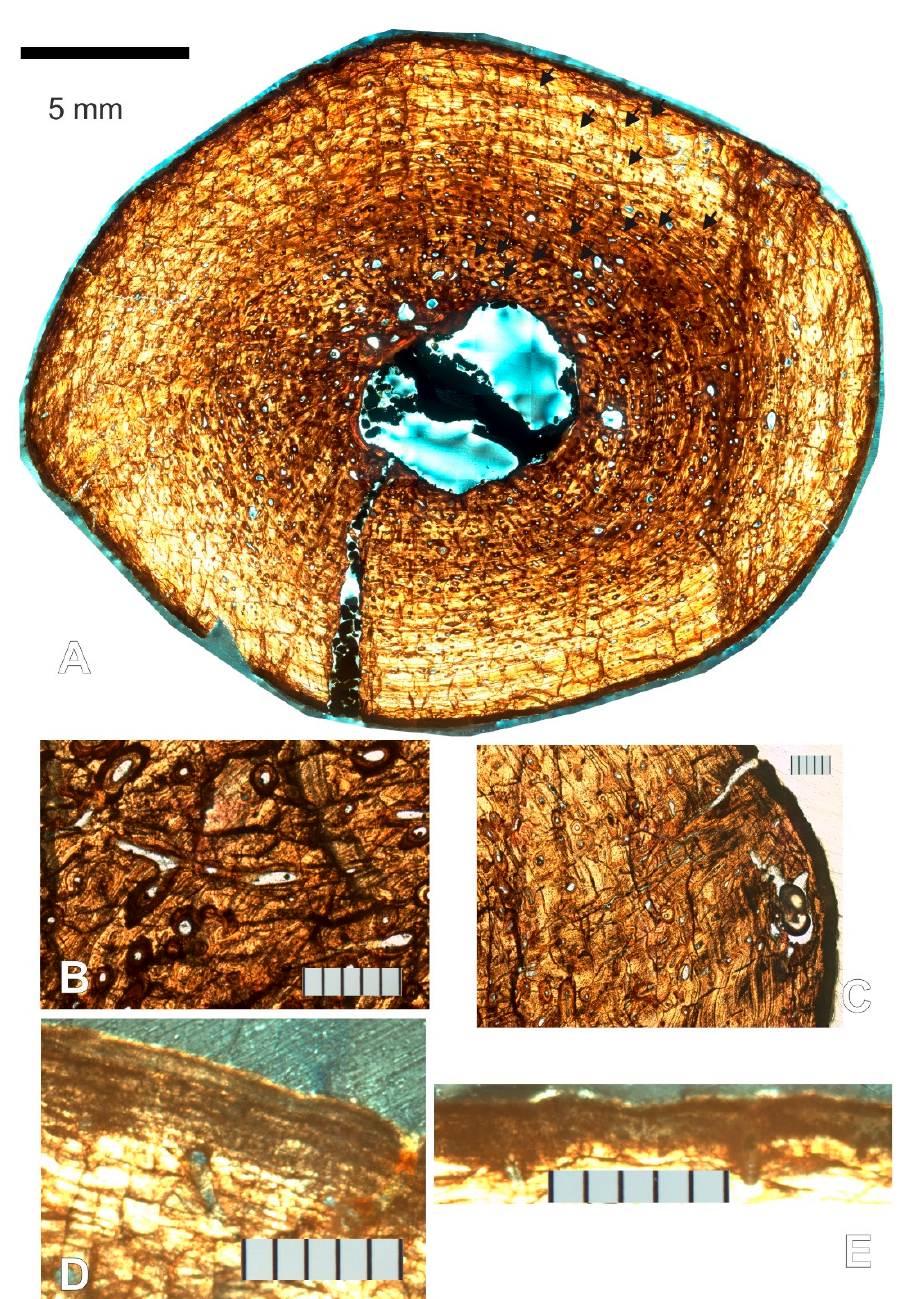
Figure 10. Mid-diaphyseal transverse thin section of the right femur of NJSM 23368, H. rogersii . All scale bars except for that in A are 500 µm; ( A ) Slide 1 under CPL. Top of the image is anterior, right is medial. Glauconite is visible filling a crack that leads to the medullary cavity, where a few grains are present. The arrows point to the 14 visible CGMs. Scale bar is 5 mm; ( B ) Secondary osteons with reticular anastomoses in slide 2 under ordinary transmitted light; ( C ) Sharpey’s fibers are present through the periosteal surface of slide 2, photographed under ordinary transmitted light; ( D ) Closely stacked LAGs suggestive of an EFS can be seen through the obscure diagenetic band at the periosteal surface of slide 2 under CPL; ( E ) Other segments of the perimeter of slide 2 (even under CPL as shown) reveal only dark irregularly shaped vacuities that may represent Wedl